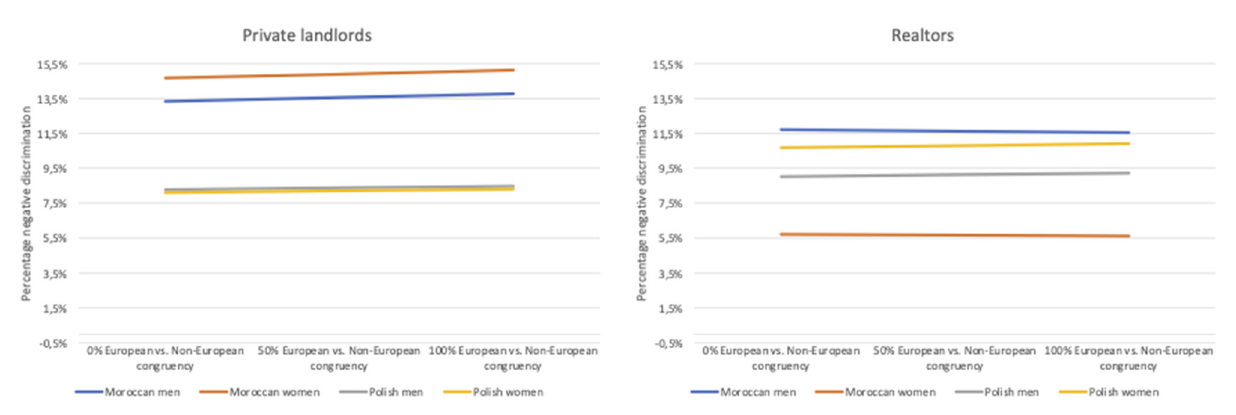
FIGURE3 The effect of the correct perception of a name as European or not on the percentage negative discrimination, controlled for the number of bedrooms.